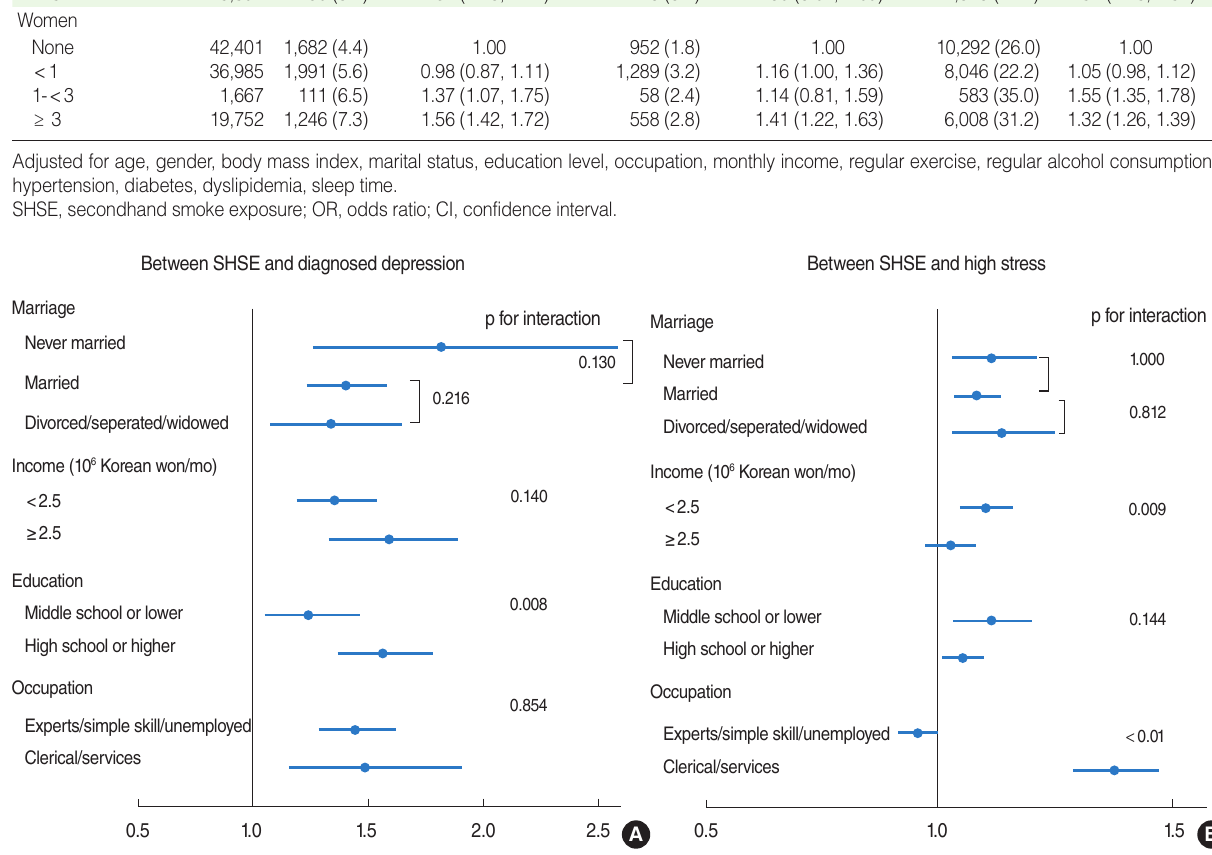
Figure 2. Association between secondhand smoke exposure (SHSE) and mental health problems (A: diagnosed depression, B: high stress) by sociodemographic factors. Odds ratio and 95% confidence interval adjusted for age, gender, body mass index, marital status, education level, occupation, income, regular exercise, alcohol drinking, hypertension, diabetes, dyslipidemia, sleep time. SHSE was divided into two groups; no SHSE (reference) and